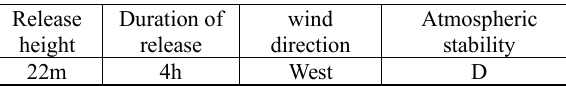
Table 3. Design parameters of wind tunnel experiment